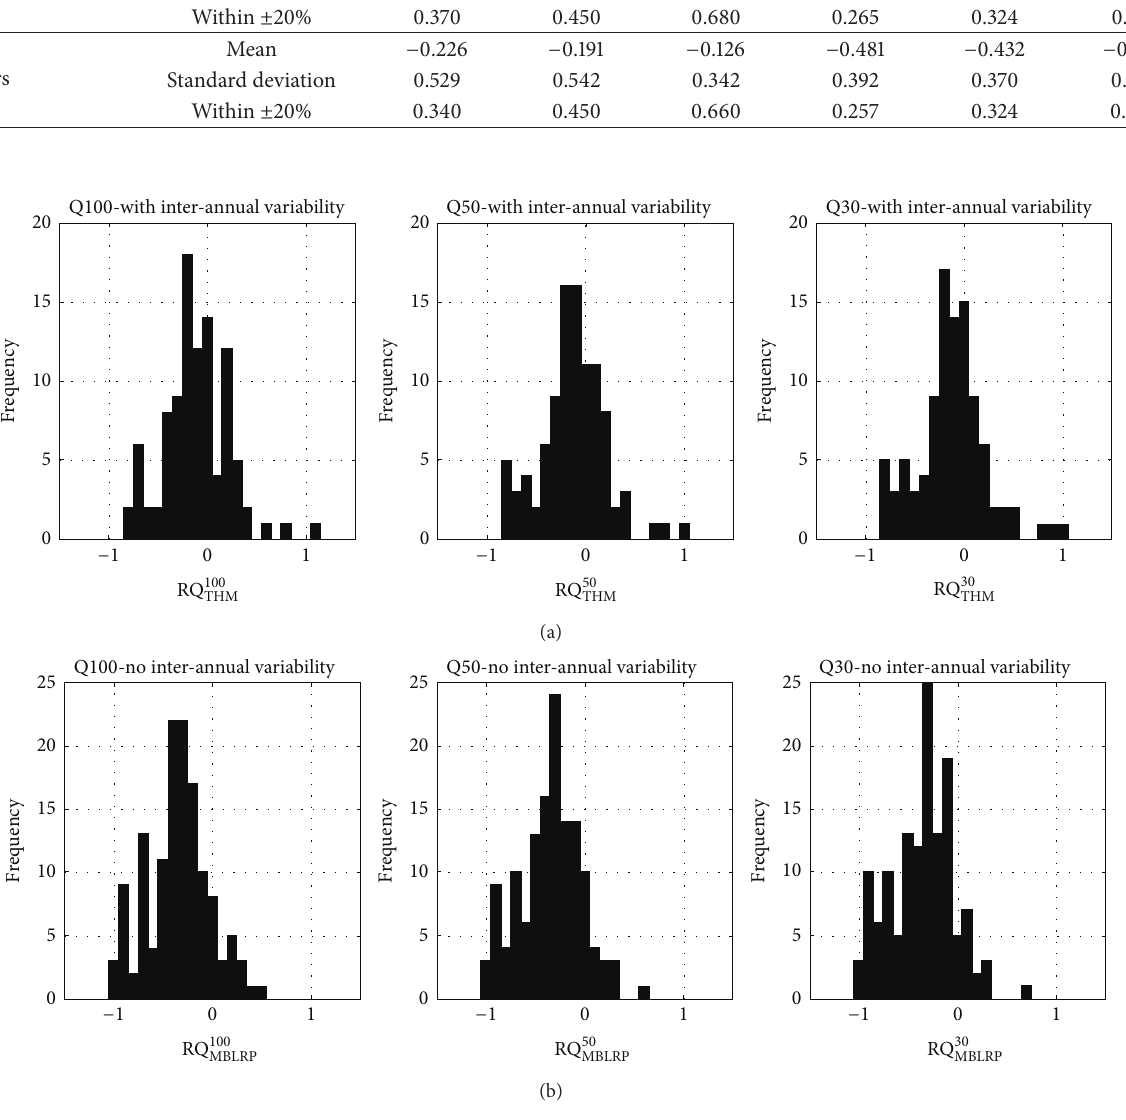
Figure 15: Histogram of the residual of design flow at the virtual watershed with curve number 90 (RF 100 , RF 50 and RF 30 ) for THM (a) and the MBLRPM